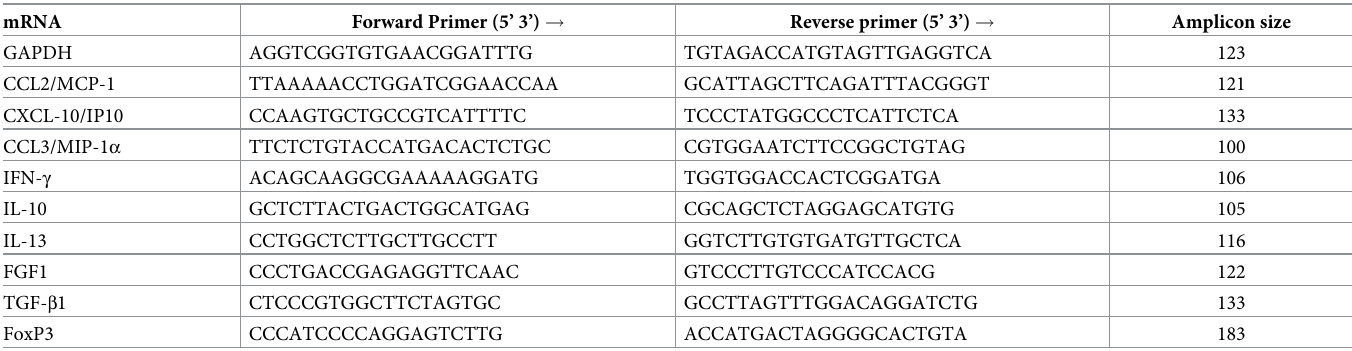
Table 3. Mice primers used for